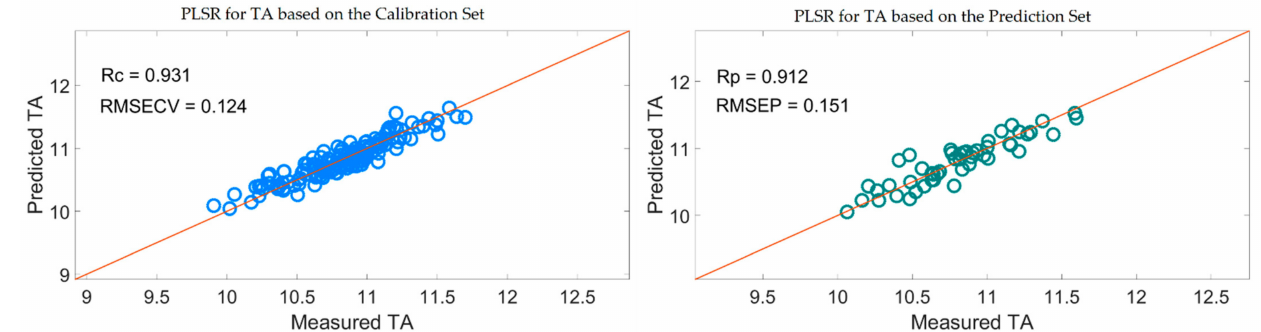
Figure 13. PLSR model for TA based on the useful wavelengths selected by